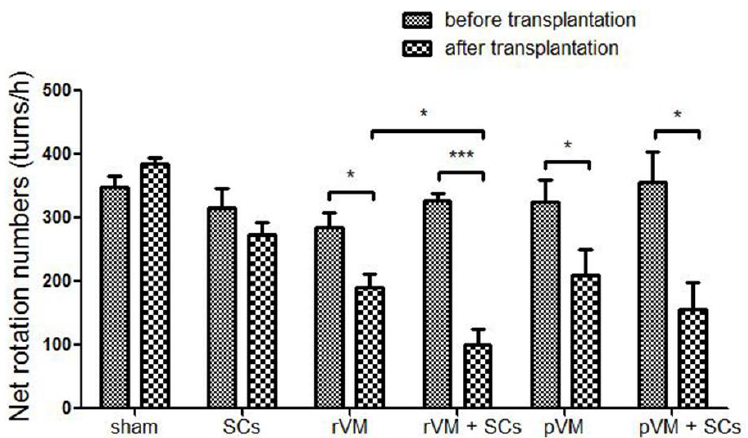
Figure 3. The apomorphine-induced rotational behavior test was used to evaluate dopaminergic (DA) function of hemiparkinsonian rats that received di ff erent neural grafts. The test was performed before and after transplantation. * p < 0.05; *** p <